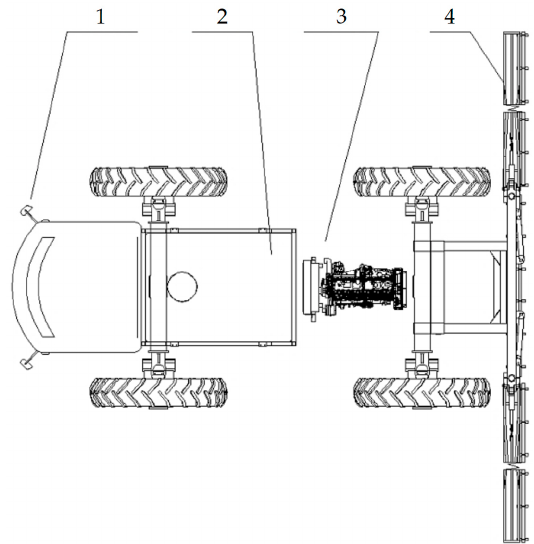
Figure 1. Overall arrangement plan of spraying machine. 1. Cockpit 2. Medicine cabinet 3. Engine 4. Spray bar.